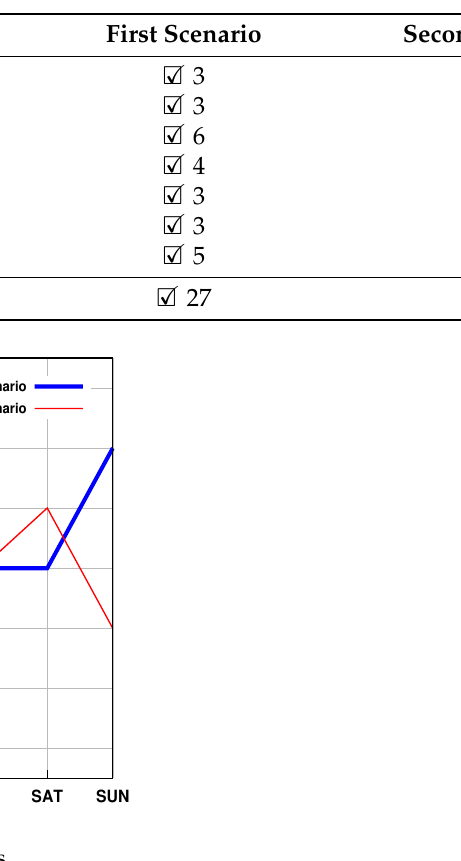
Figure 17. Glucose device